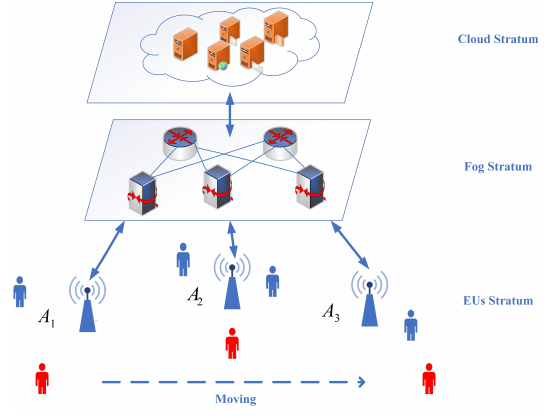
Figure 1. An example of dynamic service